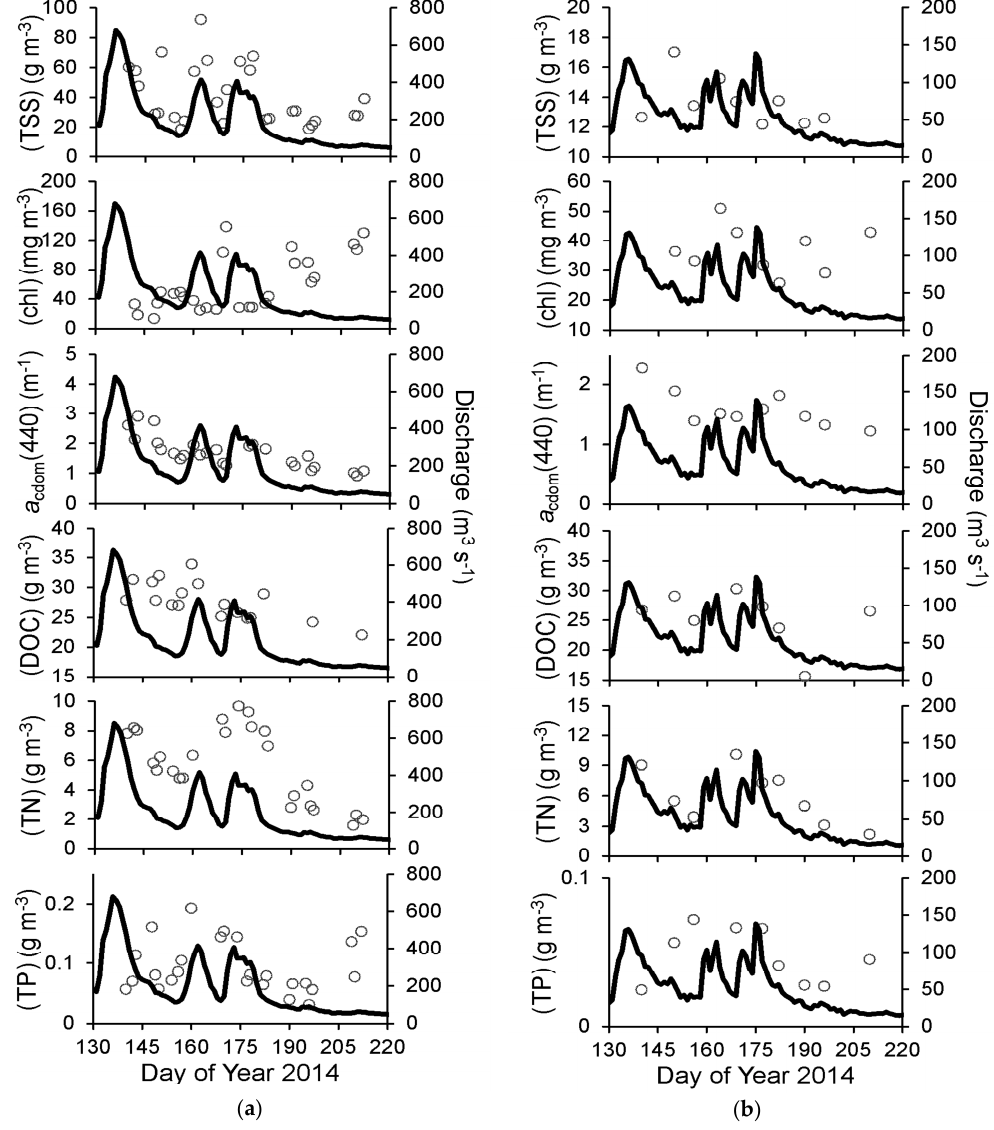
Figure 3. Time series of measured concentrations of water quality parameters and nutrients (circles) versus streamflow (solid line) of: ( a ) the Wabash River; and ( b ) the Tippecanoe River. Table 2. Pearson’s correlations between concentrations and streamflow of the Wabash River and the Tippecanoe River. The values in bold text represent those correlations that were significant ( p < 0.05).